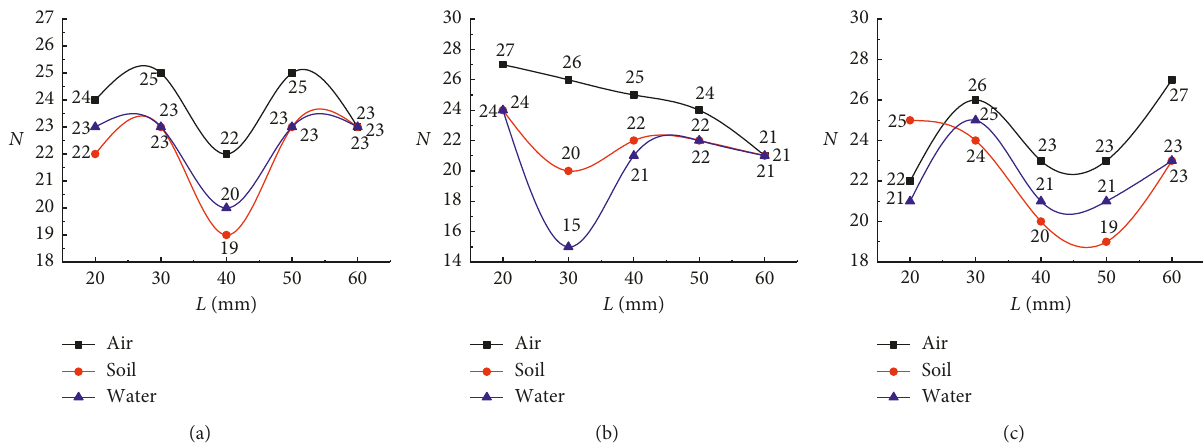
Figure 18: Relationship between fillings and the total number N of cracks in numerical simulation. (a) θ � 0 ° ; (b) θ � 45 ° ; (c) θ � 90 °